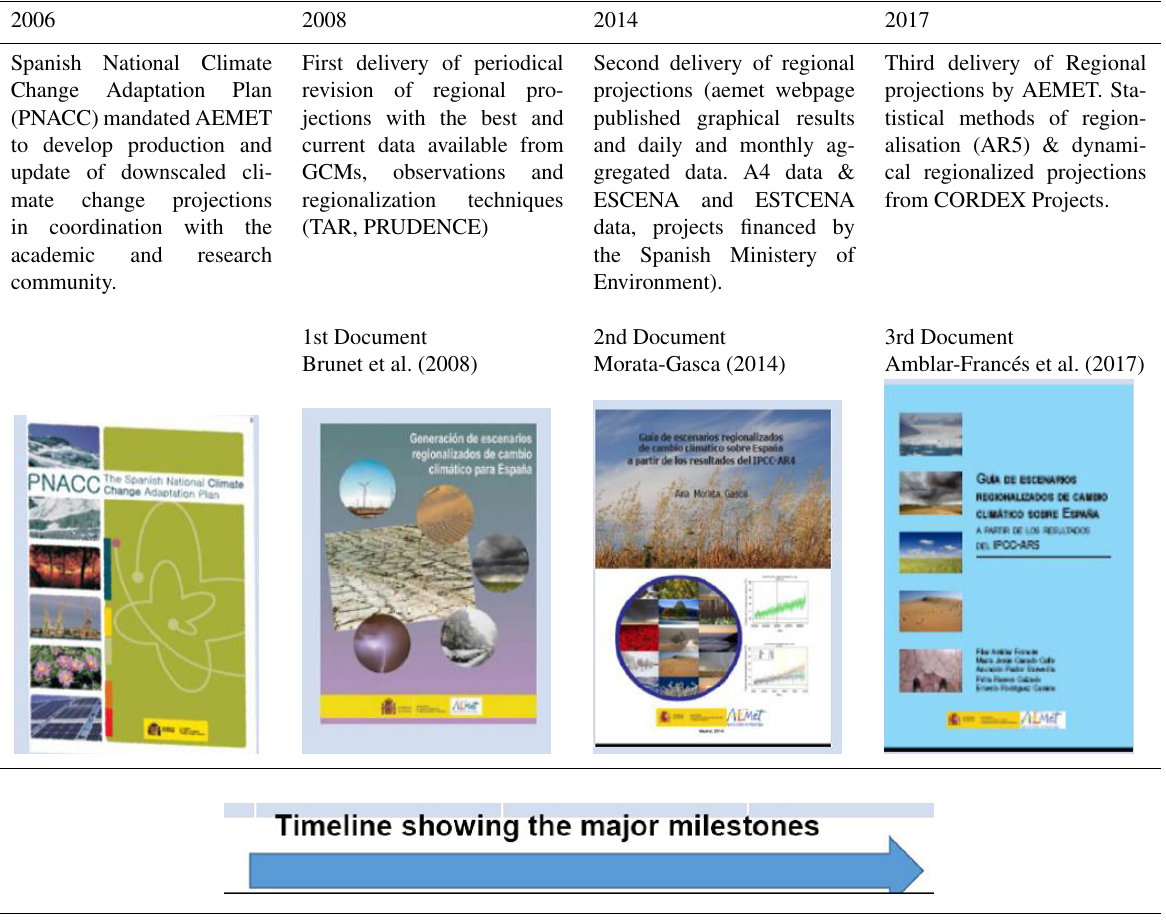
Table 1. Timeline showing the major milestones in the AEMET